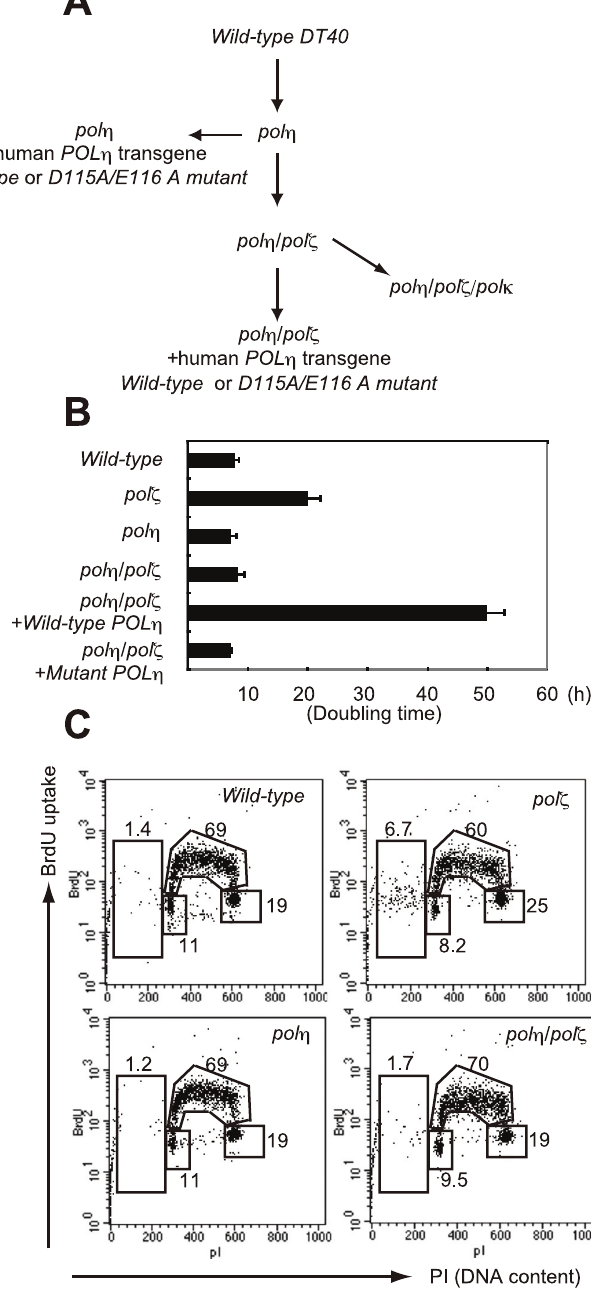
Figure 1. Proliferation of chicken DT40 pol f , pol g , and pol g /pol f cells. (A) Schematic representation of the generation of the mutant cells used in this study. (B) The pol g and pol g /pol f mutants grew more rapidly than did the pol f cells. Cells were cultured for 3 days. The doubling time of each mutant is shown. Note that wild-type cells divide every 8 hours. ‘‘ + Wild-type POL g ’’ represents a reconstitution of pol g /pol f cells with wild-type human pol g . ‘‘ Mutant POL g ’’ carries D115A/E116A mutations, which inactivate the polymerase activity of human Pol g . Error bars show the SD of the mean for three independent assays. (C) Representative asynchronous flow cytometric cell-cycle profiles of wild-type , pol g pol f , and pol g /pol f cells. Cells were pulse-labeled with BrdU for 10 minutes and stained with propidium iodide (PI) to measure DNA content. The large gate on the left of each panel indicates the sub-G 1 apoptotic cell fraction. The lower left, arch, and lower right gates indicate cells in the G 1 , S and G 2 /M phase, respectively. Numbers show the percentage of cells falling in each gate.